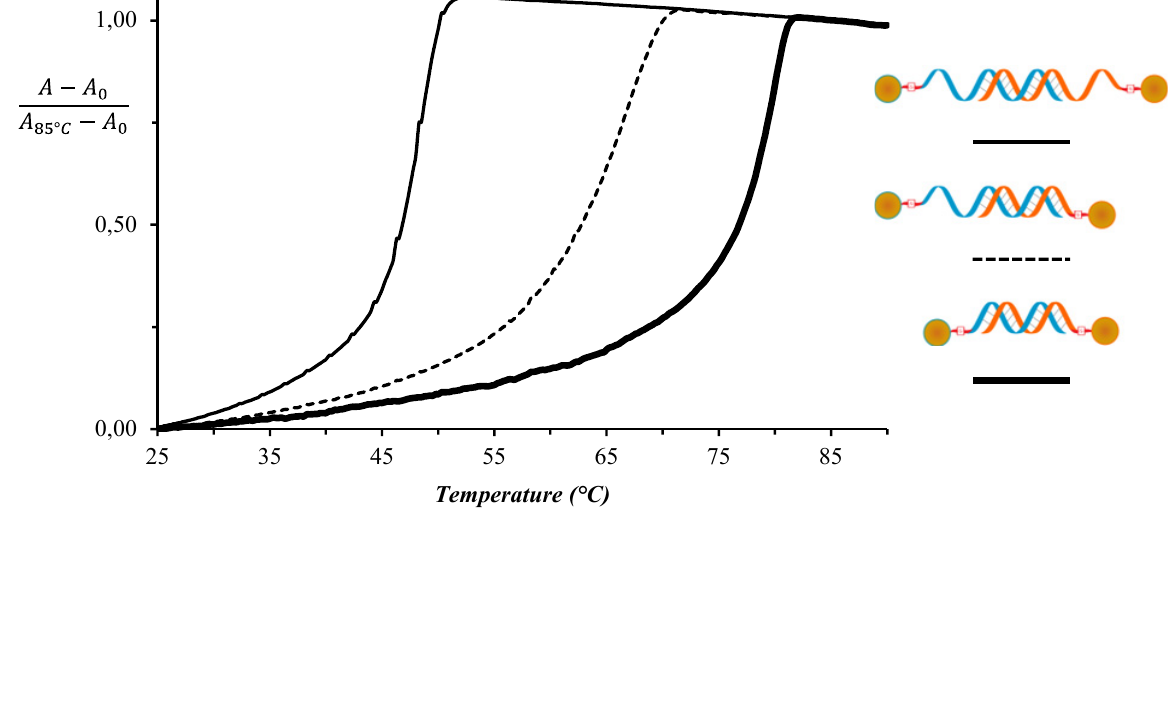
Figure A2. Normalized absorbance at 260 nm during assembly of DNA-AuNPs functionalized with the complementary oligonucleotides DNAA DNAA & T10-DNAT (dotted) and T10- DNAA 11 11 of